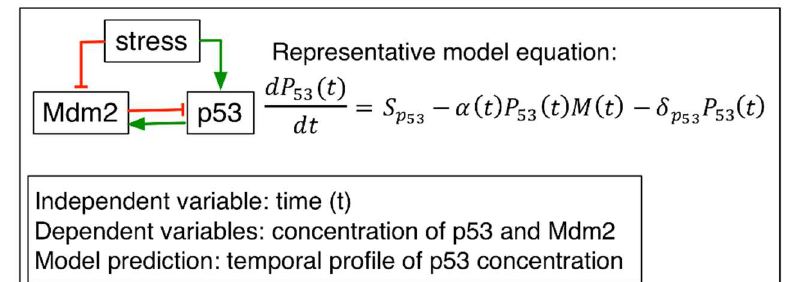
Figure 1. An ODE model developed by Lev Bar-Or et al [24]. Figure and equation adapted with permission from [24]. Copyright 2000 National Academy of Sciences of the United States of America. Left: model diagram, right: a representative model equation that describes p53 protein changes with respect to time as a function of source, degradation by Mdm2 (M(t)), and natural decay. Green line: activation or production, red line: inhibition or degradation.